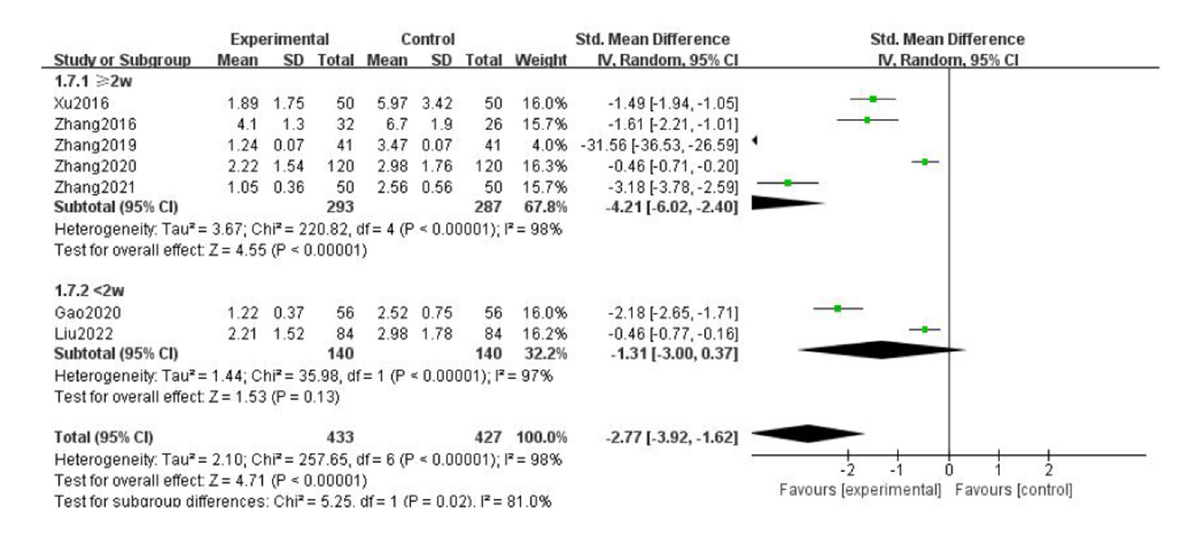
FIGURE11 Forest chart of frequency divided into subgroups according to course of treatment.